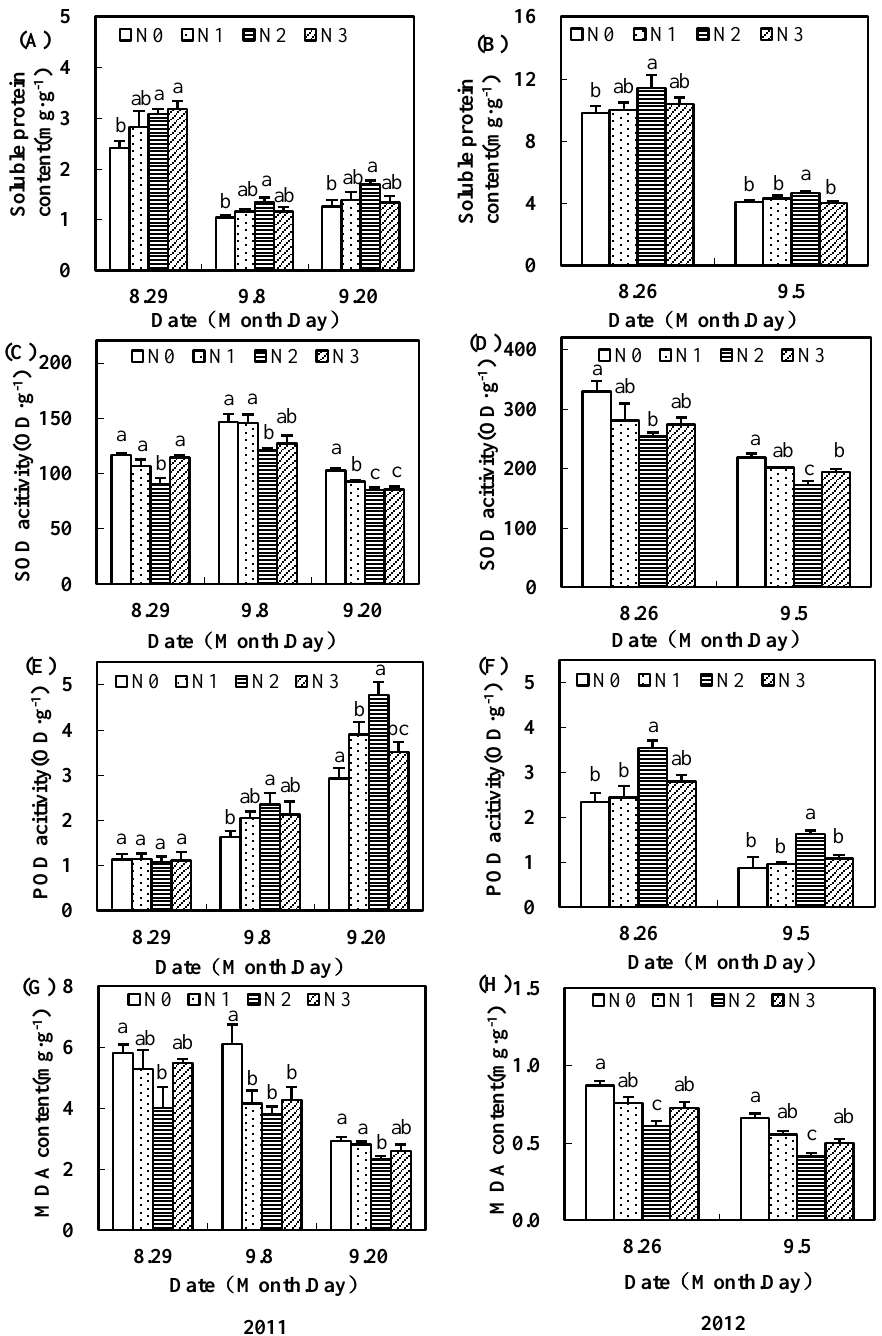
Figure 5. Effects of nitrogen fertilizer on soluble protein content ( A , B ), SOD activity ( C , D ), POD activity ( E , F ), and MDA content ( G , H ) in outer seeds of upper fruiting branches surveyed in the Yellow River Basin of China in 2011 and 2012.